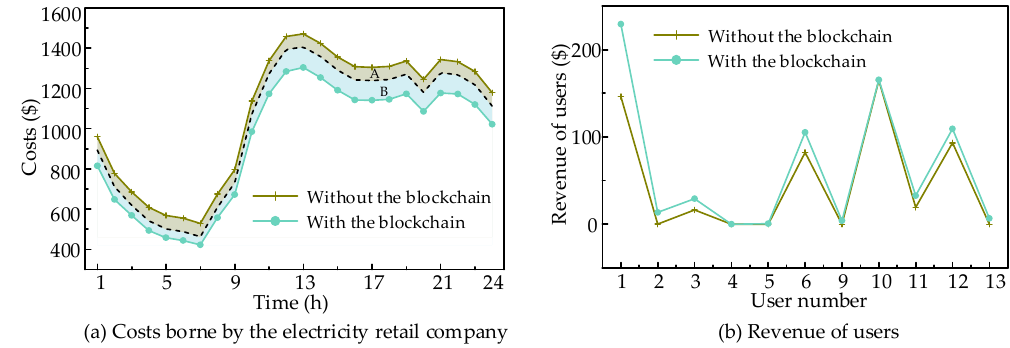
Figure 7. Comparison of the costs borne by the electricity retail company ( a ) and revenue of users ( b ) without and with the blockchain.